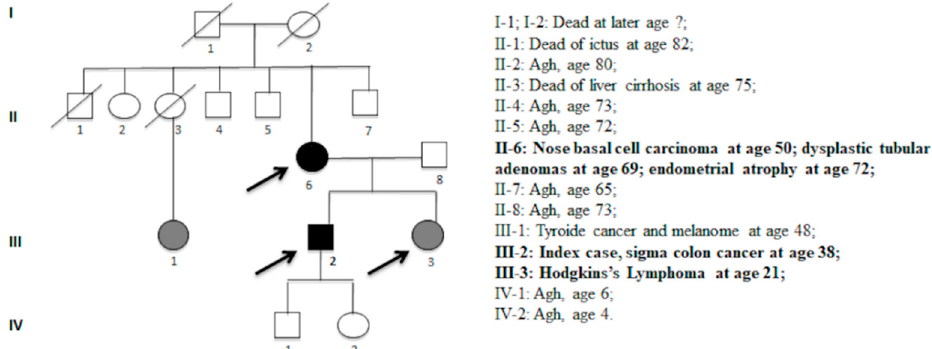
Figure 1. Pedigree with the segregation of the c.*226A > G variant. Symbols and abbreviations used are denoted as fellow: arrows, analysed members of family; black symbol, colorectal cancer or cancer associated with HNPCC; gray symbols, adenomas or cancer not associated with HNPCC. Numbers next to symbols denote age at onset; the phenotype patients are reported next to pedigree. Agh, apparent good health.